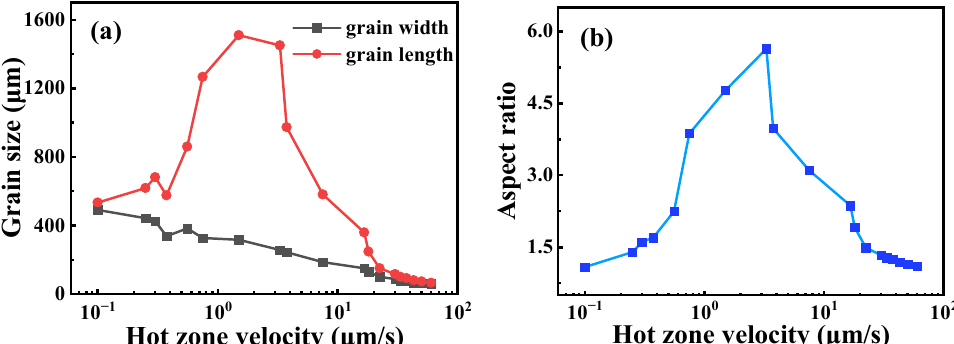
Figure 8. The relationship between drawing velocity and grain size at 900 °C. ( a ) grain length and grain width, ( b ) aspect ratio.